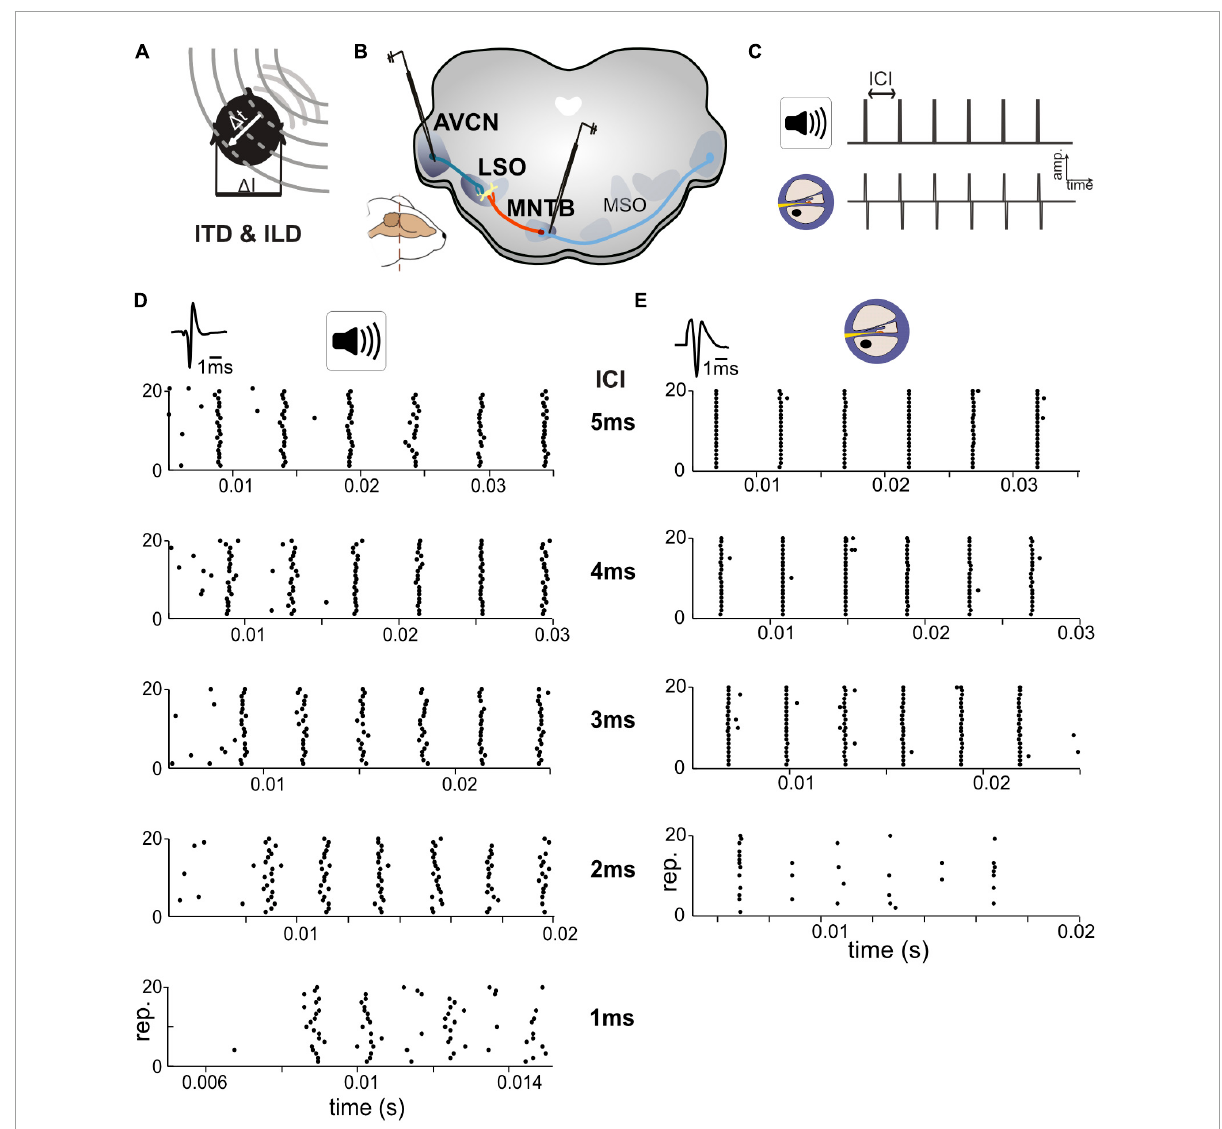
FIGURE1 Responses in auditory brainstem neurons differ between acoustic and electrical stimulation. (A) The egocentric location of a sound source in the horizontal plane generates specific interaural time differences (ITDs) and interaural level differences (ILDs). (B) Extracellular single cell recordings with glass pipettes were conducted in either the antero-ventral cochlear nucleus (AVCN), medial nucleus of the trapezoid body (MNTB), or lateral superior olive (LSO). (C) Acoustic and electrical [i.e., cochlear implant (CI)-based] stimulation consisted of a train of six clicks with varying inter-click intervals (ICIs) from 5 to 1 ms. (D) Exemplary dot-raster displays of single cell recordings from MNTB [action potential (AP) waveforms shown on top] during acoustic in response to different ICIs. (E) Same as panel (D) but for electrical stimulation. Each ICI was repeated 20 times. Responses to the individual clicks are readily identifiable, particularly at larger ICIs and overall spike probability decreased with smaller ICIs. Note the difference in spike timing variability (jitter) for each click at all ICIs between acoustic and electrical stimulation.